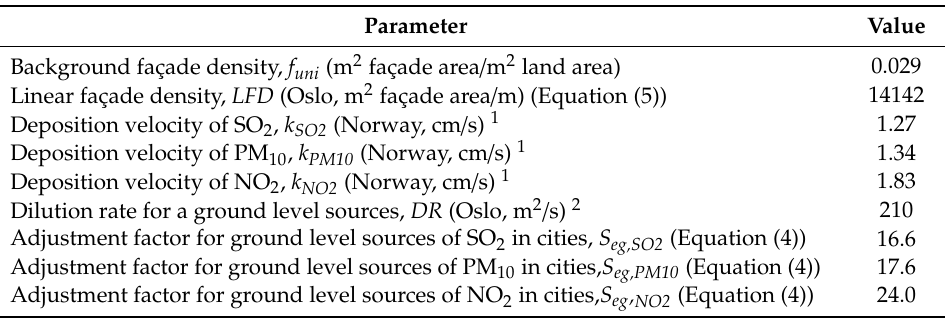
Table 2. Physical parameter values.